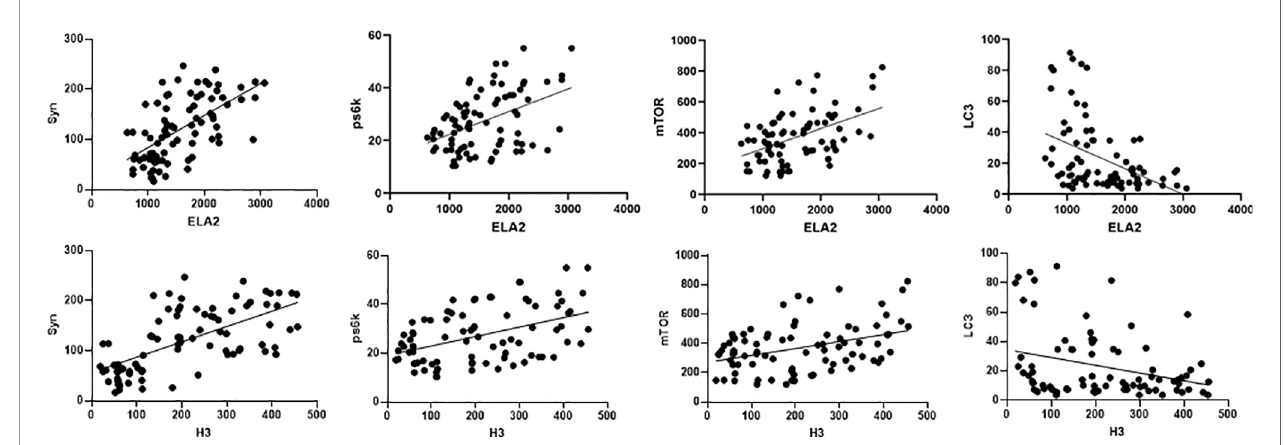
FIGURE 6 | Correlations between NET level (including ELA2 and H3), syndecan-1, and autophagy biomarkers (including PS6K, mTOR, and LC3B) in patients